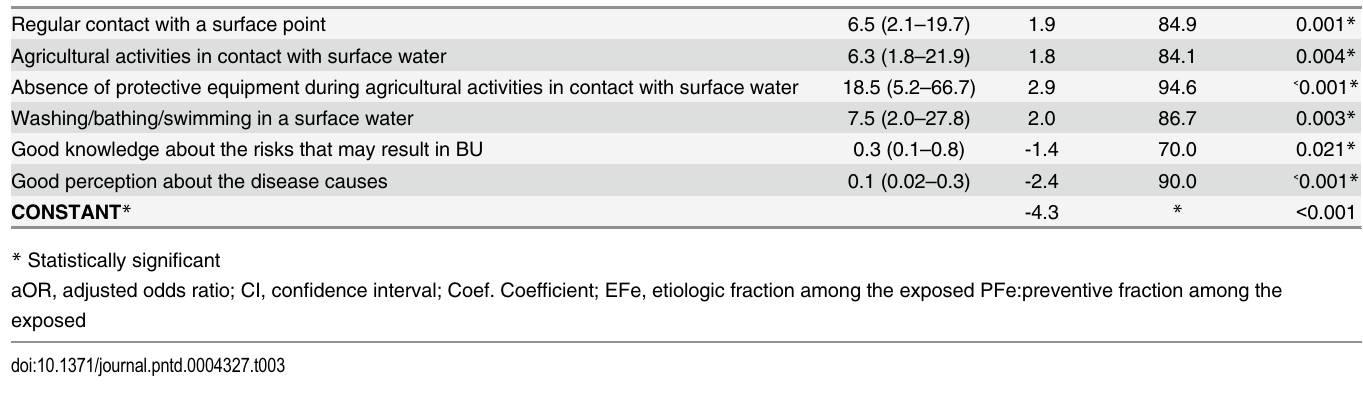
Table 3. Multivariate backward elimination model of conditional logistic regression for risk factors for BU in the district of Tiassalé, south Côte d'Ivoire (case-control study, August-September 2012).